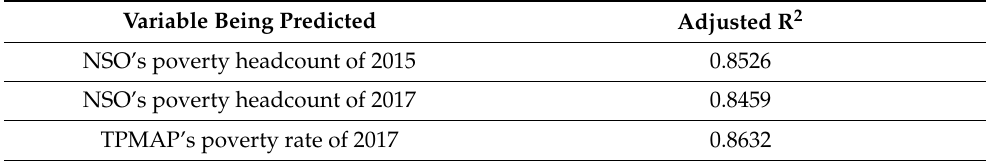
Table 3. Adjusted R 2 values for RF-based